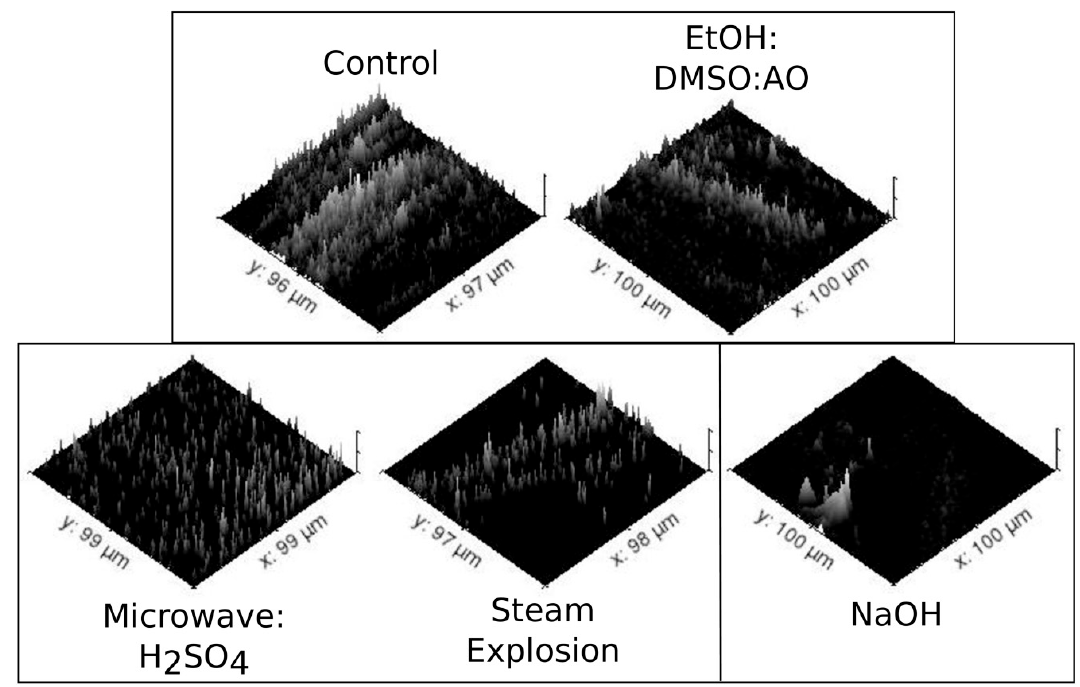
Figure 2. Mixture Discriminant Analysis and distribution patterns of Li + on the surface of sugarcane bagasse. Pretreatments are grouped into conjuncts. The normalized spatial concentration patterns for released Li + , Li + [O − ] n and Li + [OH − ] n from the surface of pretreated sugarcane bagasse is presented. Parallel ridges of Li + records were observed on the surfaces of control materials, Steam Explosion and Ethanol: Dimethyl Sulfoxide: Ammonium Oxalate (EtOH:DMSO:AO) pretreatments. The periodic arrangements in fringe and lattice structures positively correlated with the positioning of fibrils only for control and EtOH:DMSO:AO pretreatments, once Steam Explosion destroyed that arrangement.